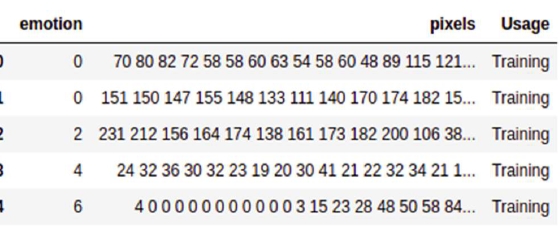
Table 1 . Sample of dataset